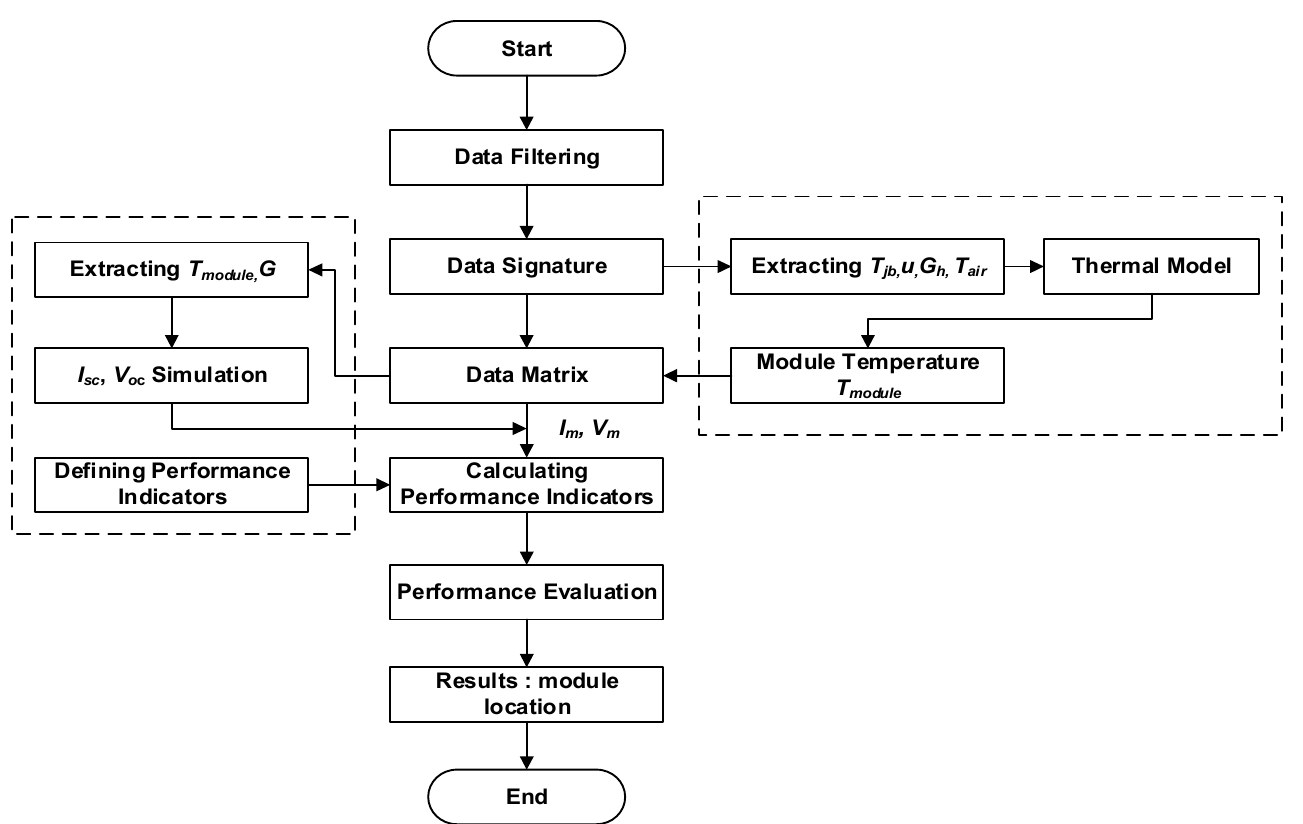
Figure 10. Performance evaluation process of the smart PV system at module level.